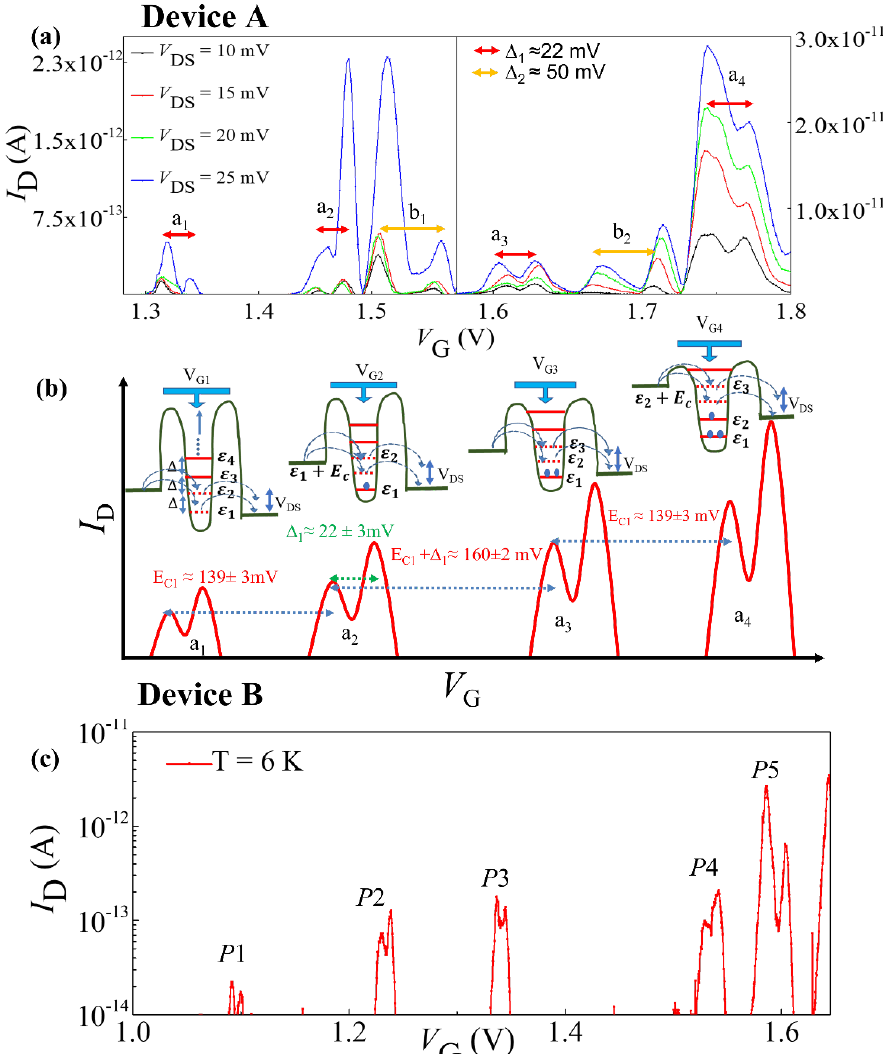
Figure 3. Device A ( a ) I D − V G characteristics measured at T = 5 K, depicting also the single-electron- tunneling current peaks a 1 – a 4 and b 1 , b 2 , likely originated from QD 1 and QD 2 , respectively. ( b ) Schematic summarization of tunneling transport through the QD 1 , suggesting the variable-barrier QCB. Device B ( c ) I D − V G plot shows the SET transport through isolated P − donors in uniformly-doped SOI-FET channels.